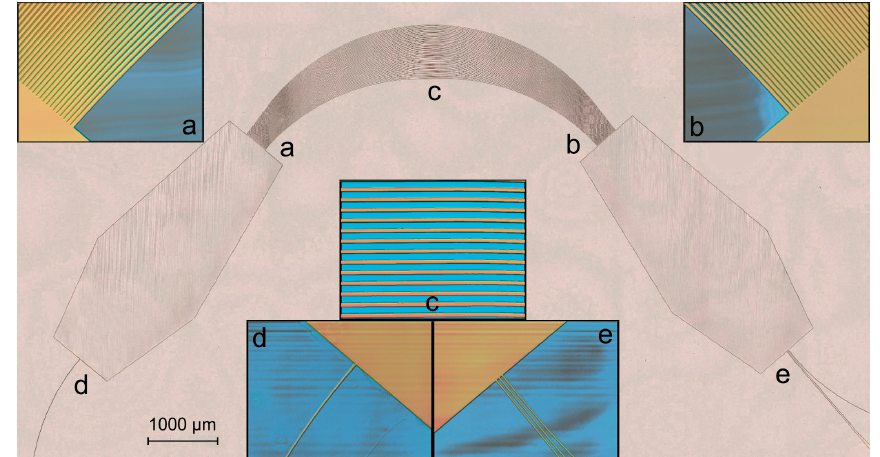
Figure 1. Laser scanning microscope images of the arrayed waveguide grating (AWG) manufactured with the described parameters. Between the end of the first free propagation zone (a) and the beginning of the second free propagation zone (b), the 50 arrayed waveguides are arranged (c). At the entrance to the first free propagation zone is the input waveguide (d) and at the exit of the second free propagation zone are the three output waveguides (e). The height of the entire structure is homogeneously 3.2 µm. In order to have low insertion losses, the input waveguide is vertically cut and then